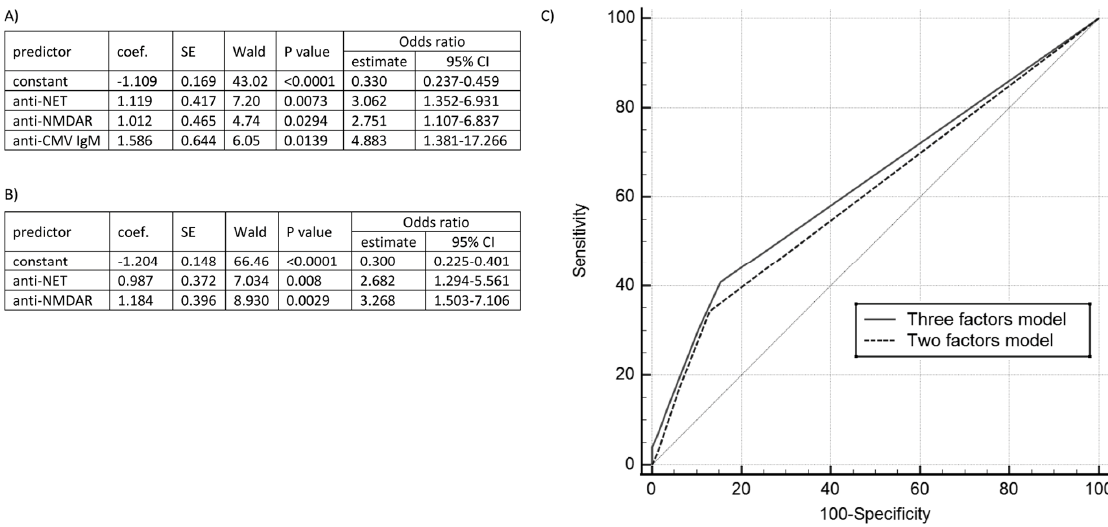
Figure 2. The logistic regression models. ( A ) The three ‐ factor model characteristics (PCC = 70.71%; SP = 84.66%; SE = 40.79%). ( B ) The two ‐ factor model characteristics (PCC = 71.97%; SP = 86.73%; SE = 34.09%). ( C ) The models’ comparison. Abbreviations: CMV—cytomegalovirus, NET—neuroendo ‐ thelium, NMDAr—N ‐ methyl ‐ D ‐ aspartate receptor, PCC—a percentage of consonants correct; SE— sensitivity; SP—specificity.